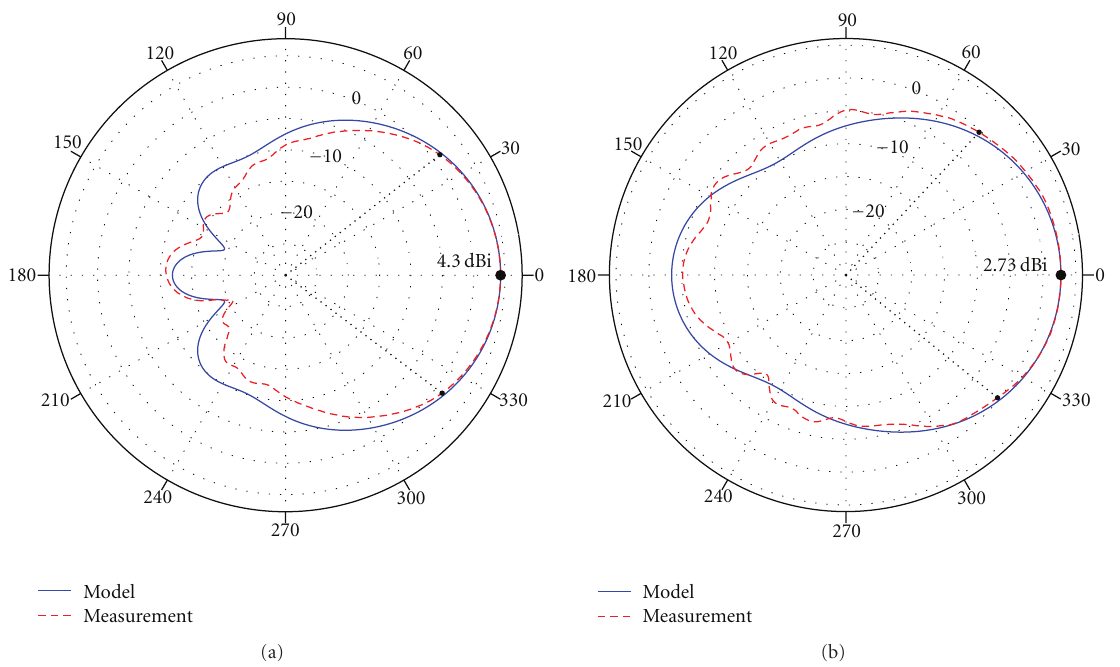
Figure 6: Radiation pattern in XY plane of prototype 1 for 1.567 GHz when bent in the W p direction. The bending radii are 90mm (a) and 31.5mm (b).